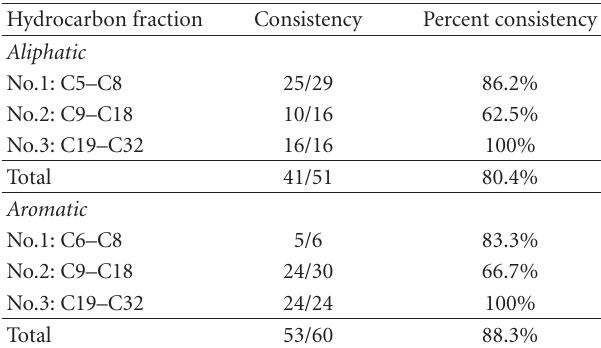
Table 2: Consistency of fraction